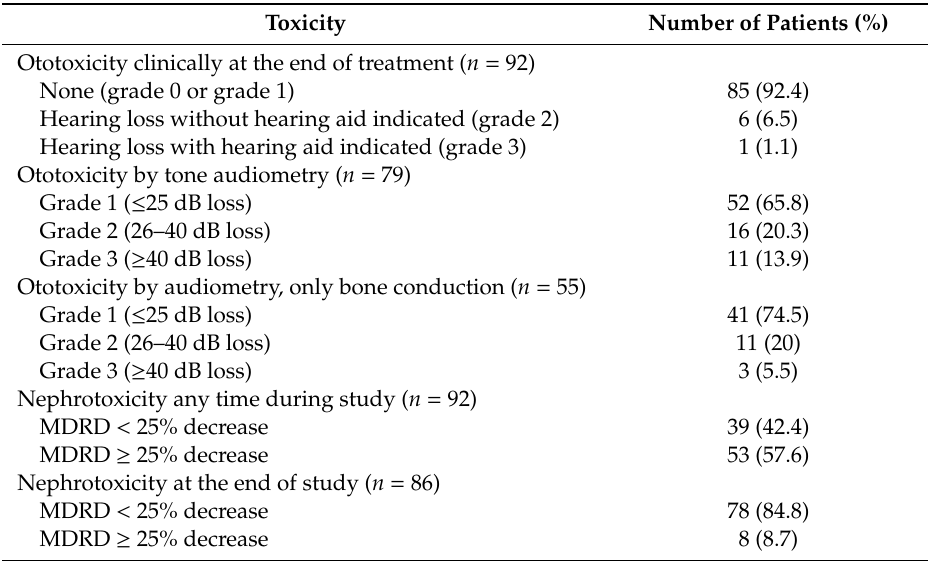
Table 2. Ototoxicity and nephrotoxicity. MDRD: Modification of Diet in Renal